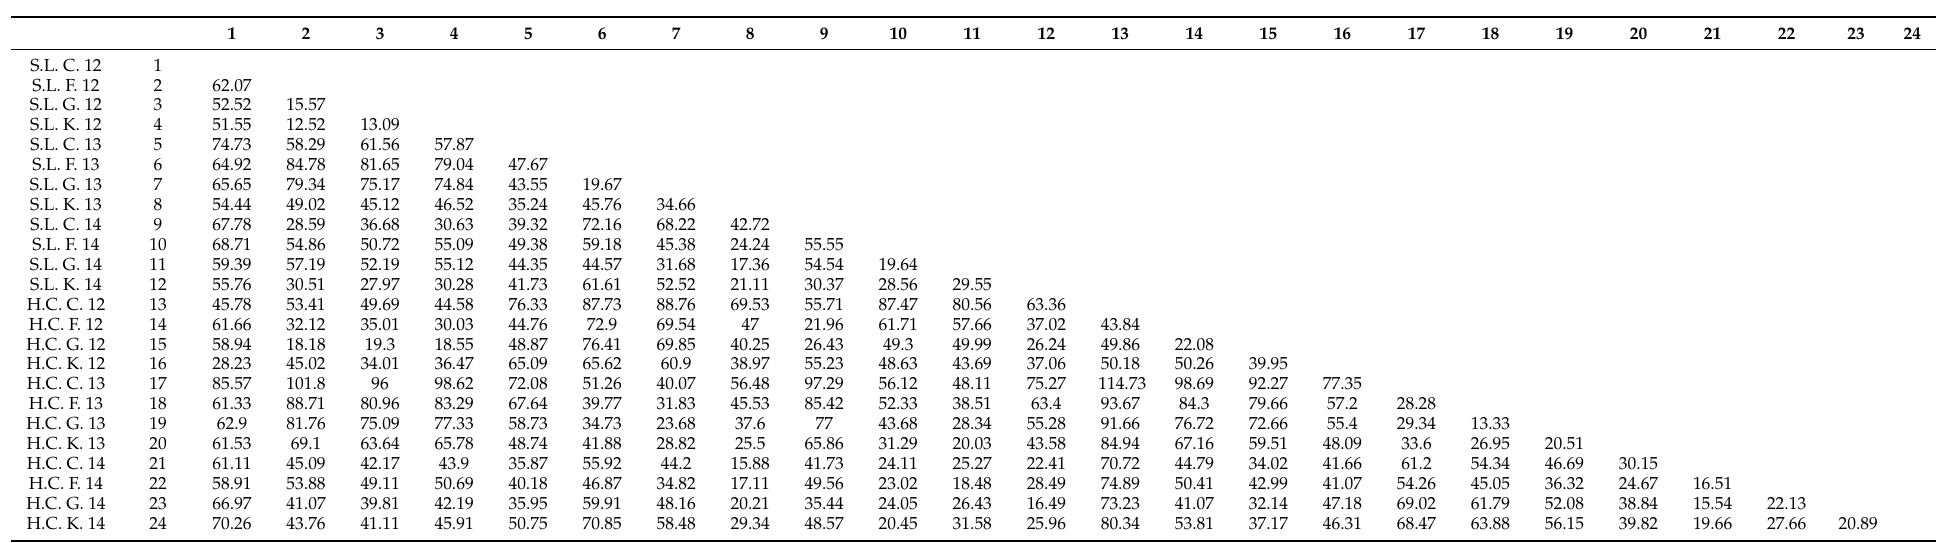
Table 17. Mahalanobis distances between pairs of combinations of three studied